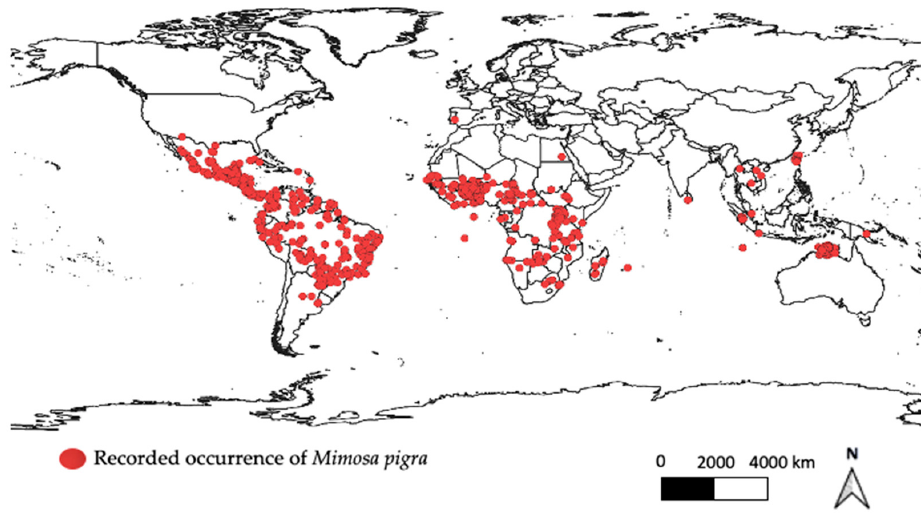
Figure 1. Global distribution of Mimosa pigra L. [36] (DOI: 10.15468/dl.d75f66).